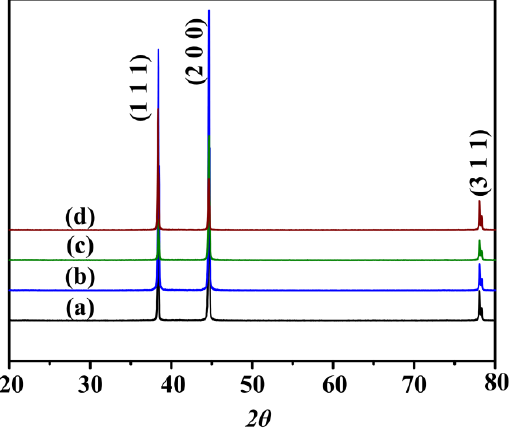
Figure 8. XRD results of ND-TD surface for 7075 T6 alloy without and with different contents of Sr addition: ( a ) 0 wt. %; ( b ) 0.05 wt. %; ( c ) 0.1 wt. %; and ( d ) 0.2 wt. % Sr.